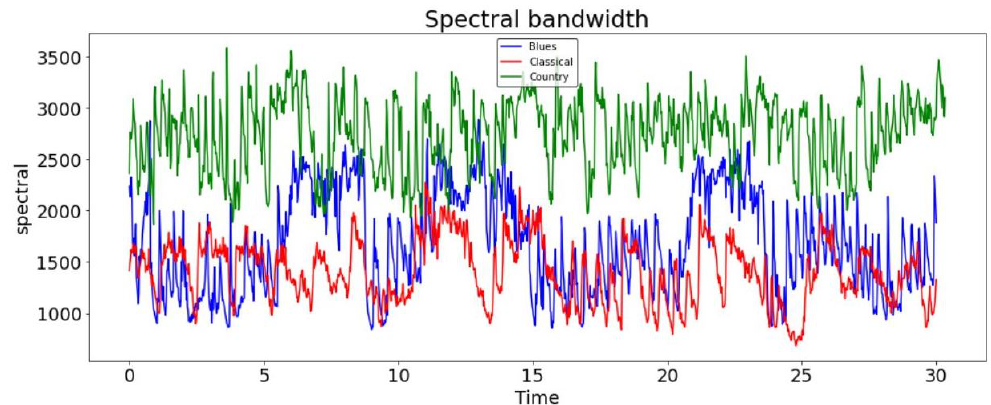
Figure 8. Spectral bandwidth (graphical representation) of blues, classical, and country genres. (c) Spectral roll-off—The roll-off frequency for each frame in the music signal is calculated by spectral roll-off. The following numerical measurements show the spectral roll-off frequency of the blues, classical, and country music genres. Therefore, spectral centroid, spectral roll-off, and spectral bandwidth are computed and visualised in this paper for the blues, classical, and country genres to analyse the frequency of these audio signals; see Figure 9.